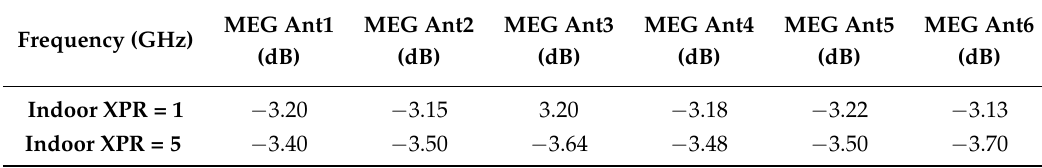
Table 1. Mean Effective Gain (MEG) for Ant1 to